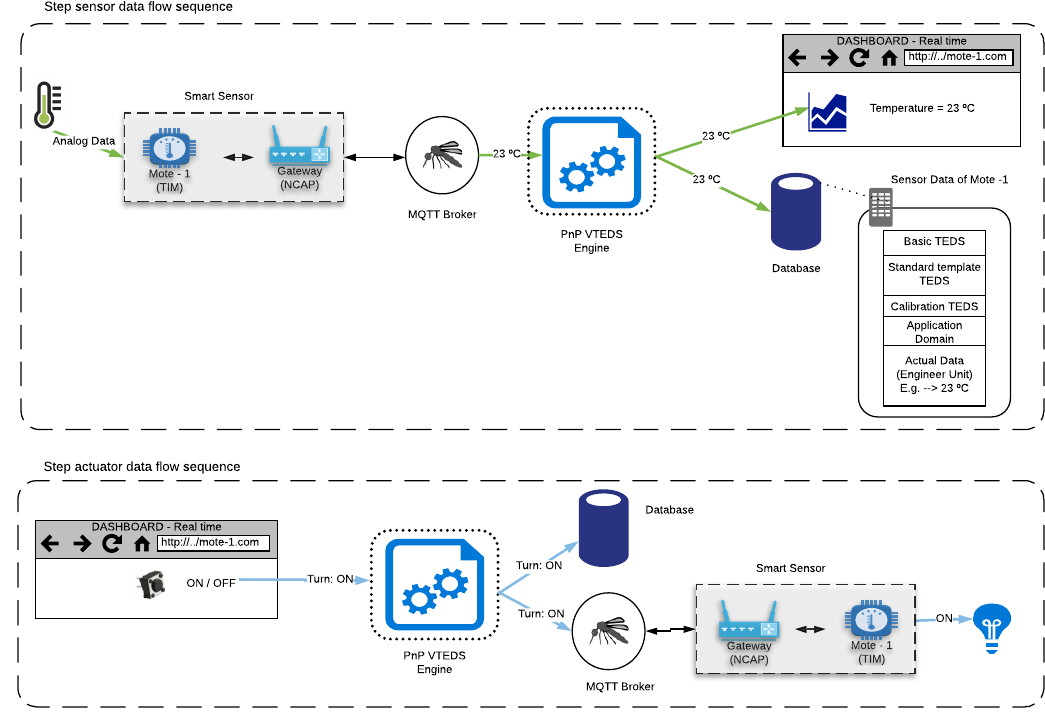
Figure 10. Data flows between sensors/actuators and Internet of Things (IoT)